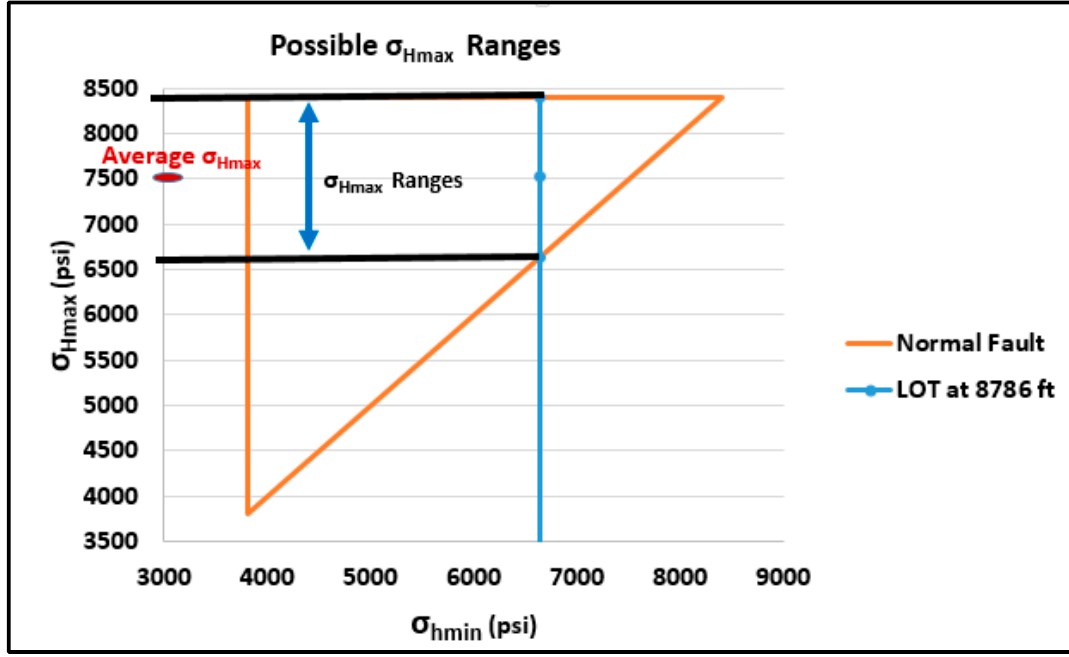
Figure 25. Possible range of ( σ Hmax) values for a normal faulting regime at a depth of 2678 m (8786 ft) TVD.